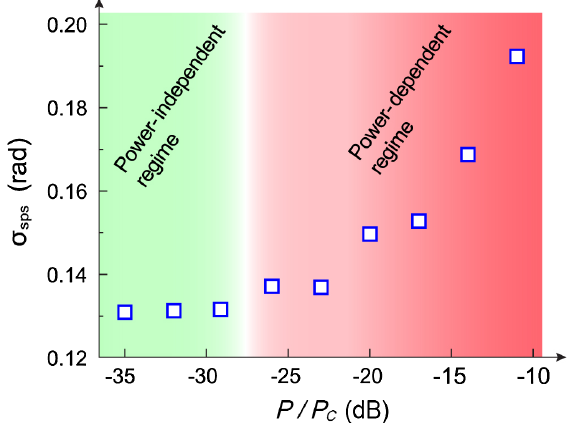
FIG. 4. Dependence of the standard deviation of SPS switching current distribution on the reduced input power of the microwave signal. The measurements are made at 60 mK. P c corresponds to a power that induces in the wires a current equal to their critical current.